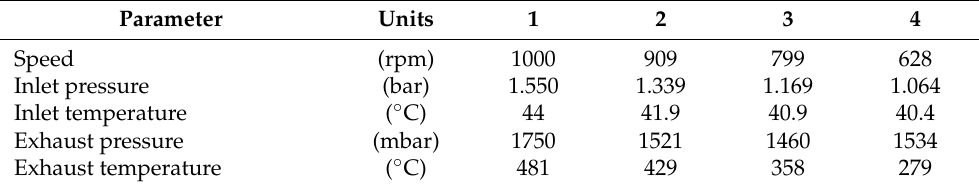
Table 3. Motoring